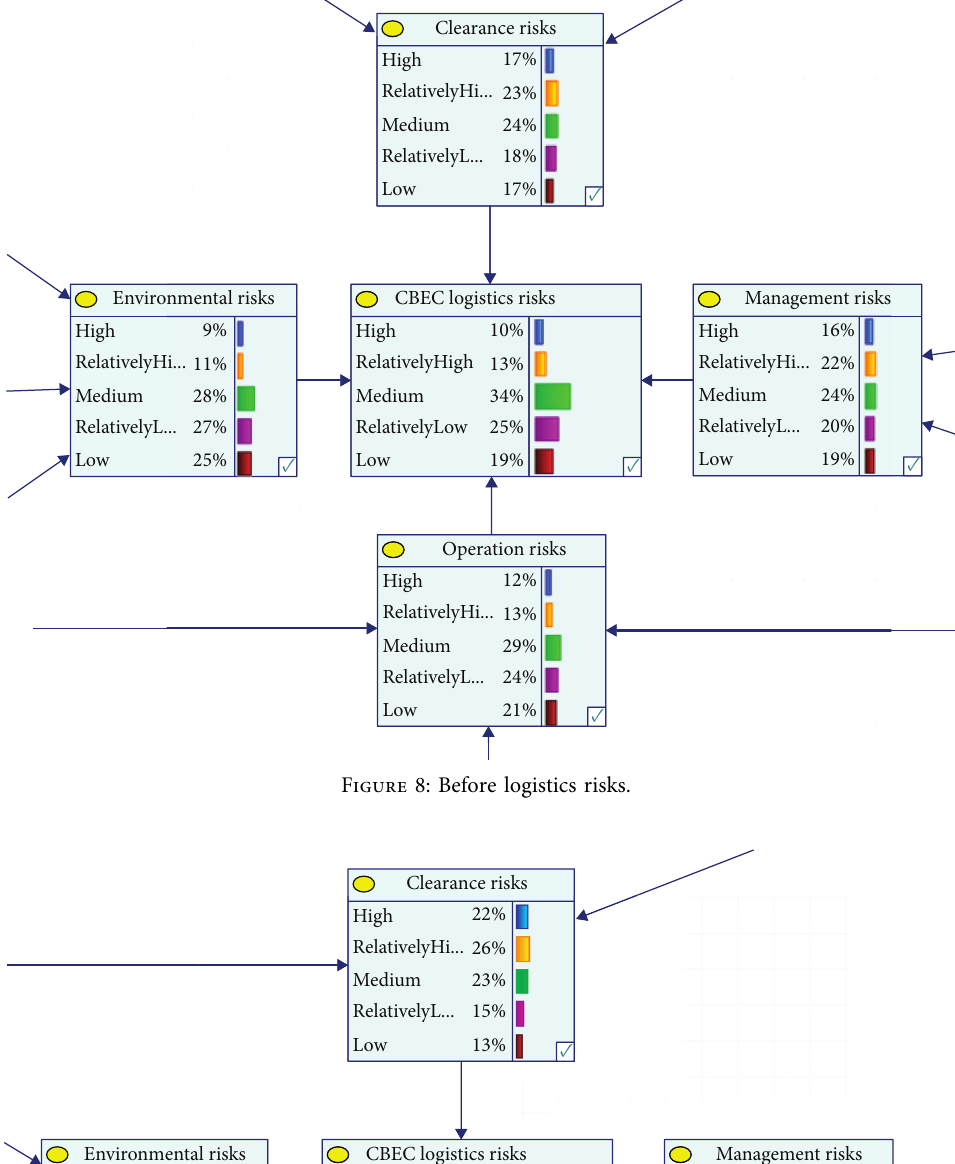
Figure 8: Before logistics risks.